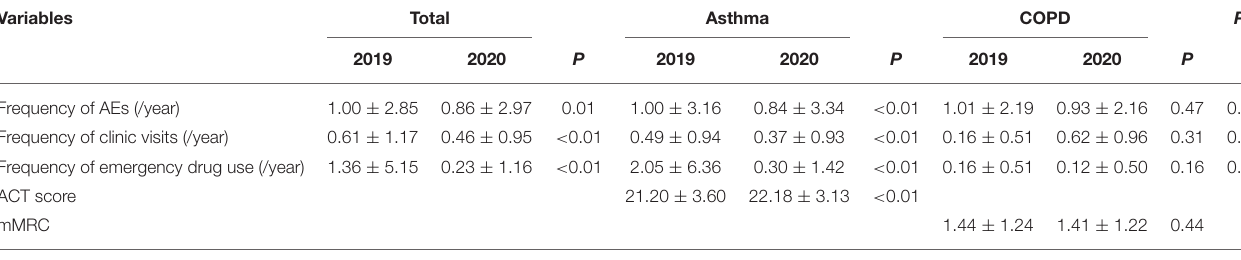
TABLE 3 | Comparisons of patients’ conditions between asthma and COPD. Variables